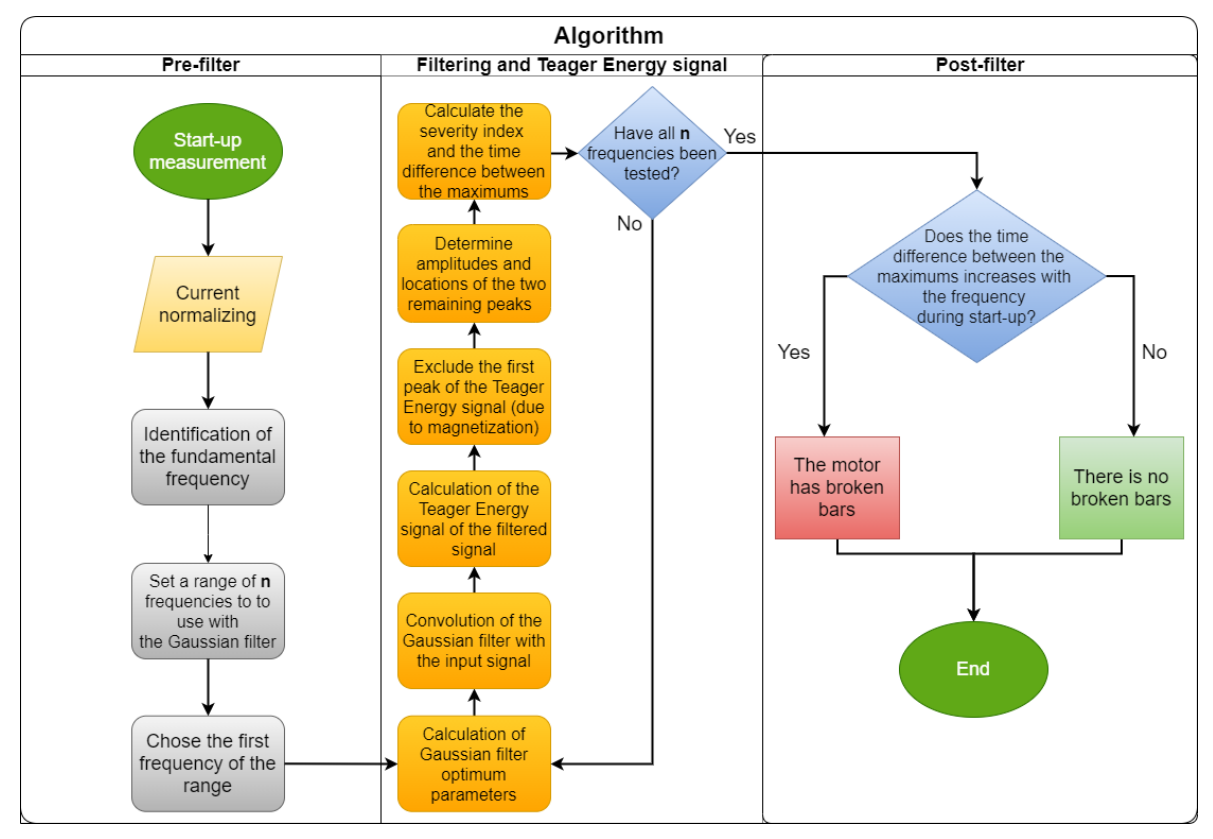
Figure 4. Algorithm flowchart.